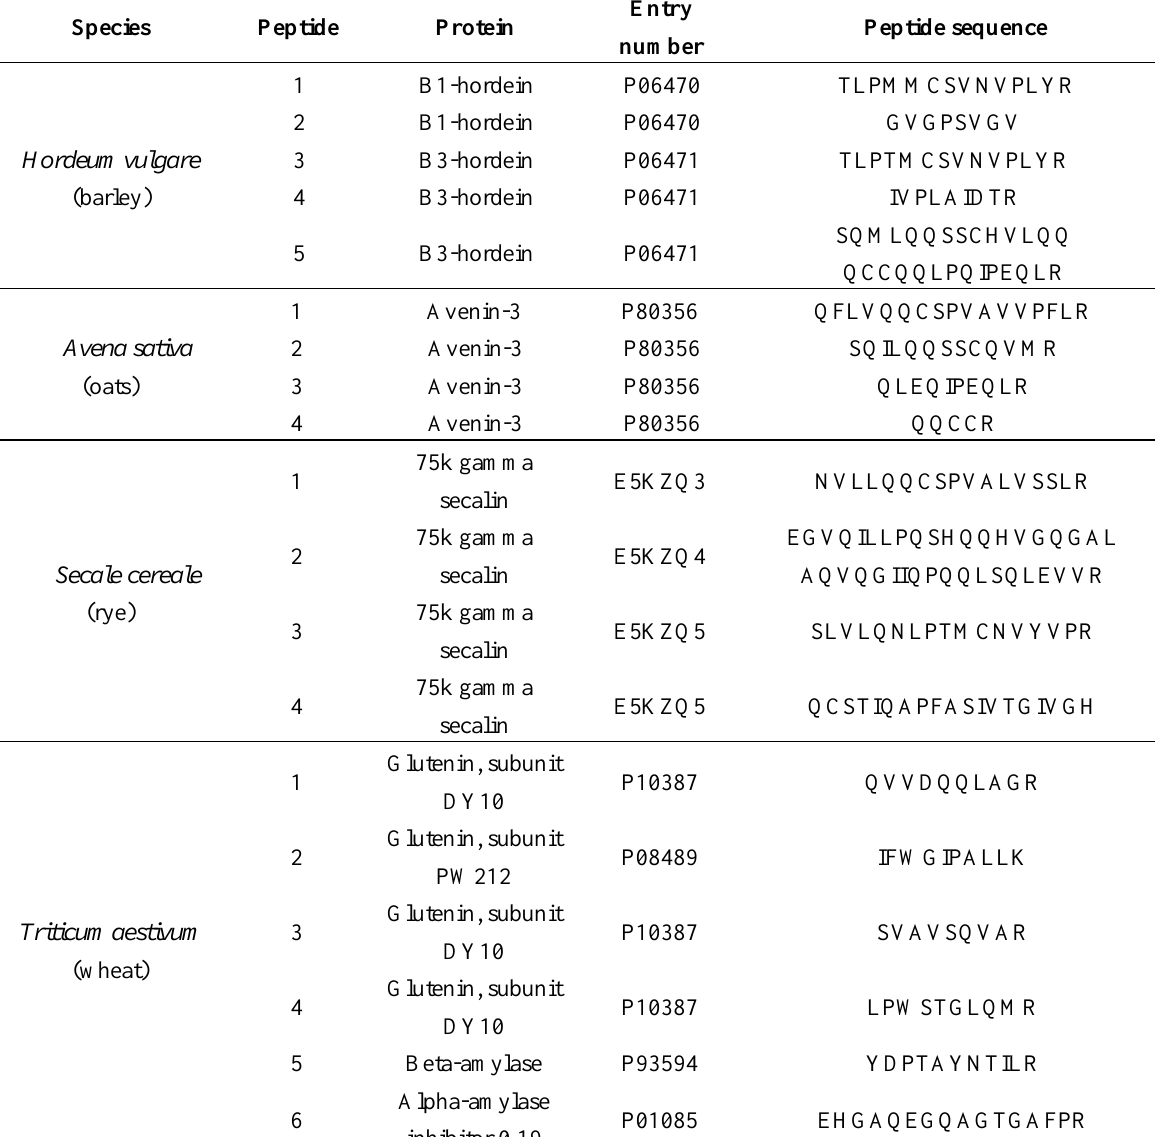
Table 3. Marker peptides and sequence information used for gluten species markers (the peptide information was taken from searches of the Swiss-Prot database